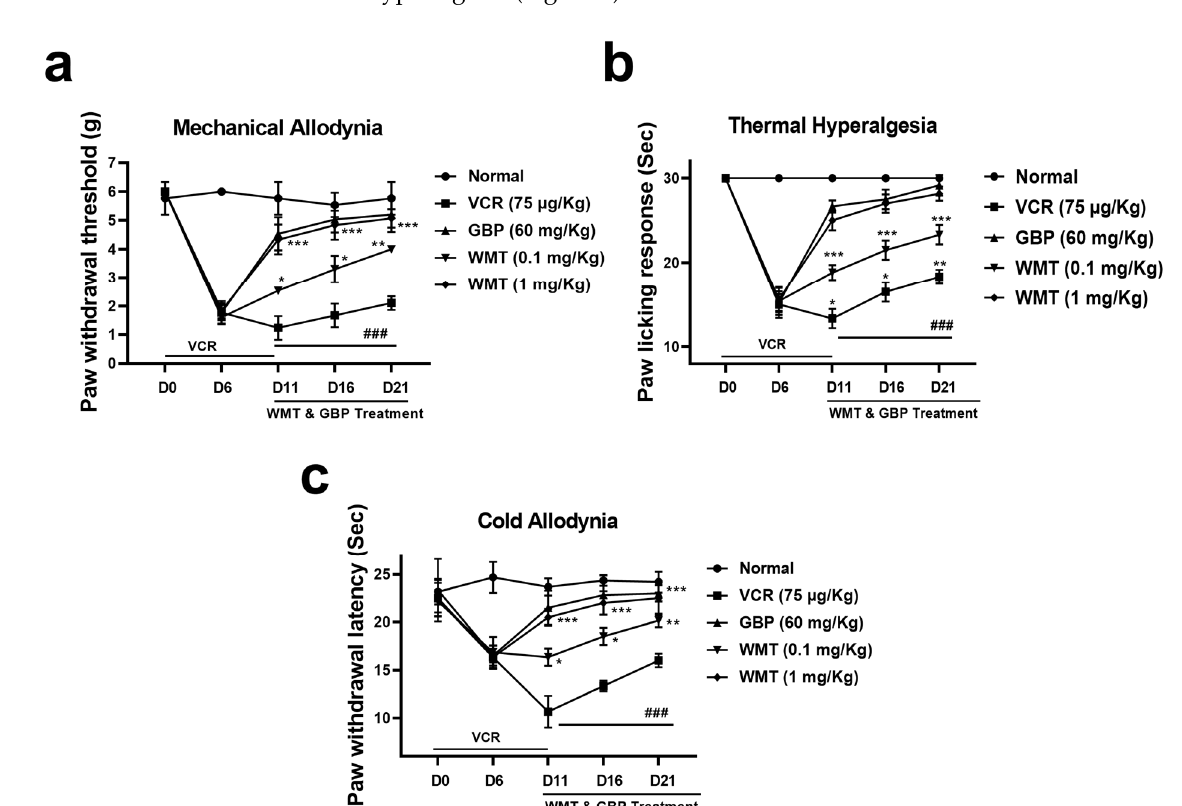
Figure 2. Effects of withametelin (0.1, 1 mg/kg) and GBP (60 mg/kg) on VCR-induced mechanical allodynia, ( a ) thermal hyperalgesia, ( b ) and cold allodynia ( c ). All results were expressed as the mean ( n = 10) ± SD. ### p < 0.001 compared to the normal control group; * p < 0.05, ** p < 0.01, and *** p < 0.001 compared to the VCR group.